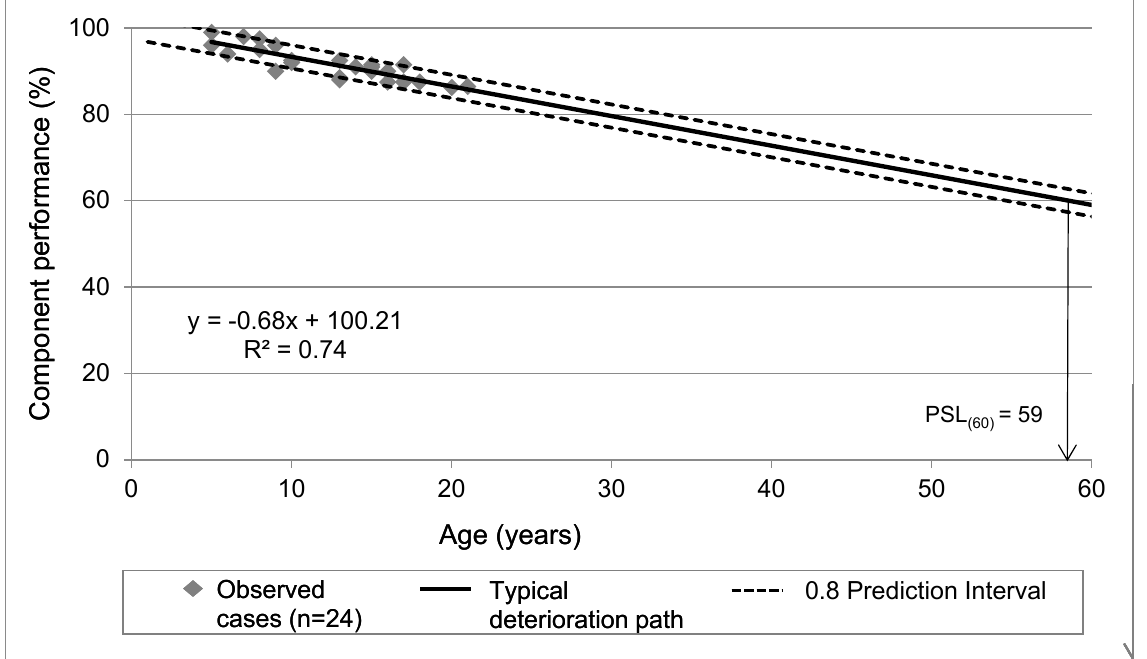
Figure 5. Deterioration pattern for dry-fixed stone claddings under standard service conditions.